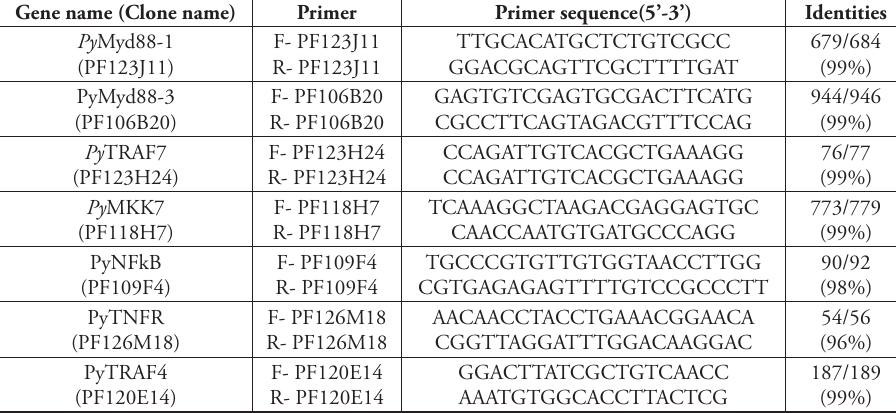
Table 2. Primers used for PCR and BNALSN results of the mapped clones. Gene name (Clone name) Primer Primer